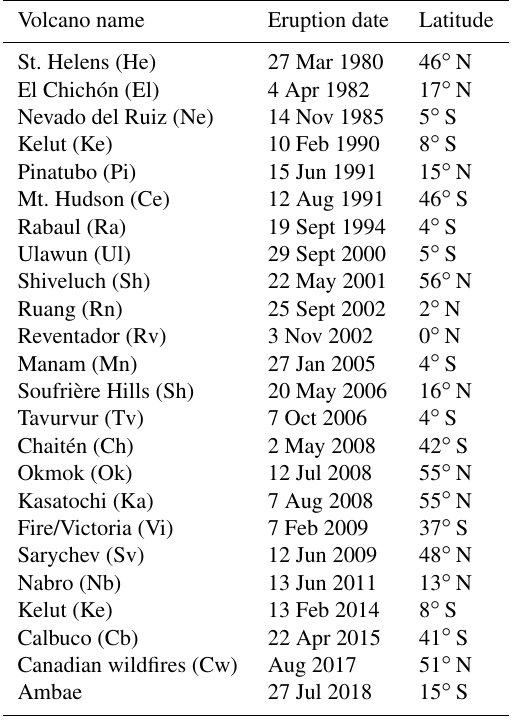
Table 1. List of significant volcanic eruptions/wild fire events that occurred during the entire record of